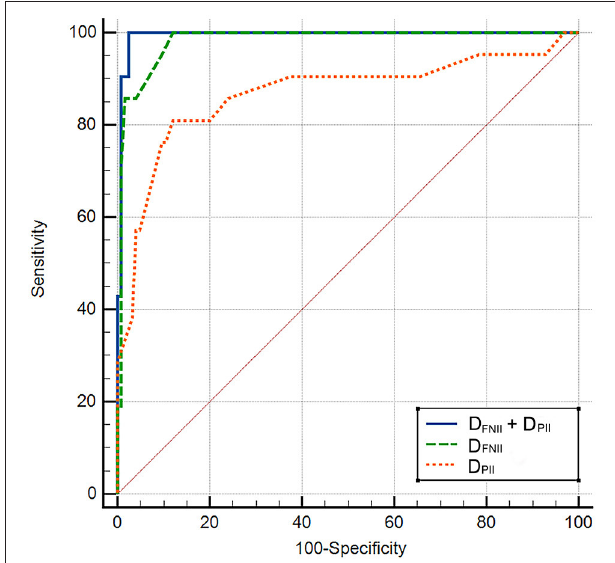
FIGURE 2 | The receiver operating curve for each model. D FNII , duration of the negative component of flutter wave in lead II; D PII , P wave duration in lead II during sinus